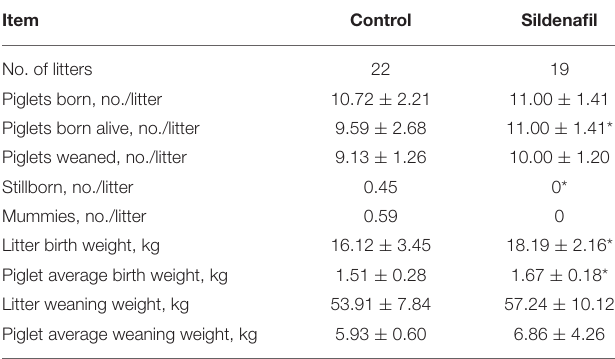
TABLE 6 | Effect of sildenafil intervention from day 30 to 110 of gestation on gilt litter performance (means ±